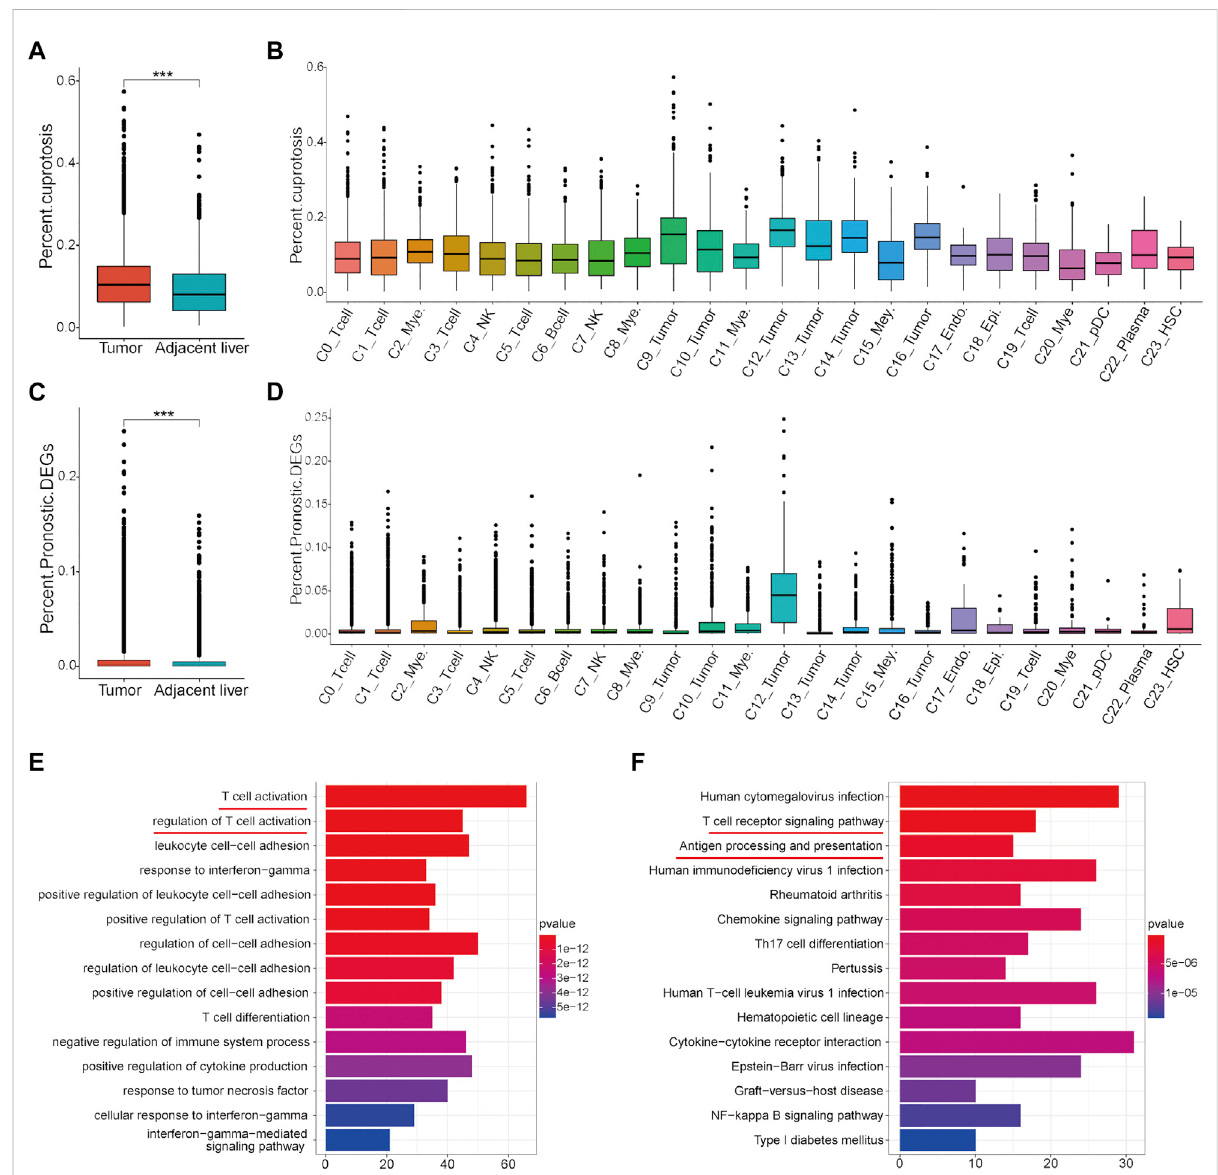
FIGURE 9 Analysis of the proportion of cell expression two gene sets in the HCC tumor microenvironment by scRNA data. (A) Differences in the proportionofcellexpressioncuproptosis-relatedgenesbetweenHCCtumortissuesandadjacentlivertissues. (B) Proportionofcuproptosis-related genes in all cell types. (C) Differences in the proportion of cells expressing the prognostic DEGs between HCC tumor tissues and adjacent liver tissues. (D) Proportion of cells expressing the prognostic DEGs in all cell types. (E) GO analysis results of the signi fi cant DEGs in tumor cell cluster-C12. (F) KEGG analysis results of the signi fi cant DEGs in tumor cell